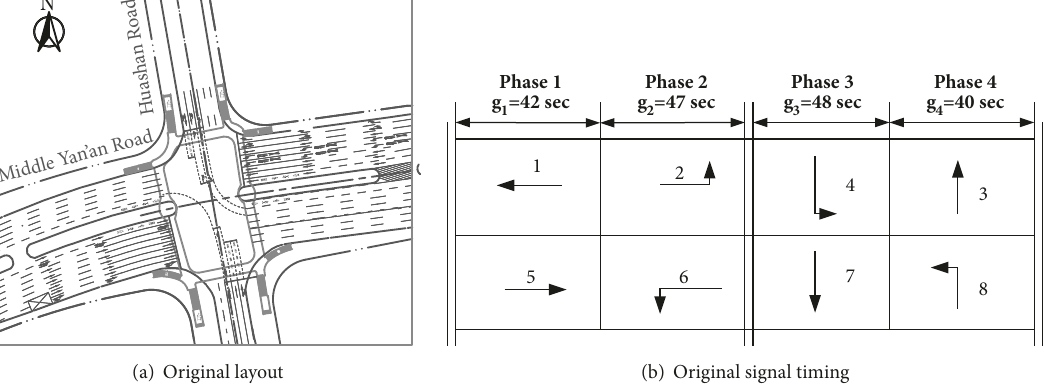
Figure 8: Original layout and signal timing of the tested